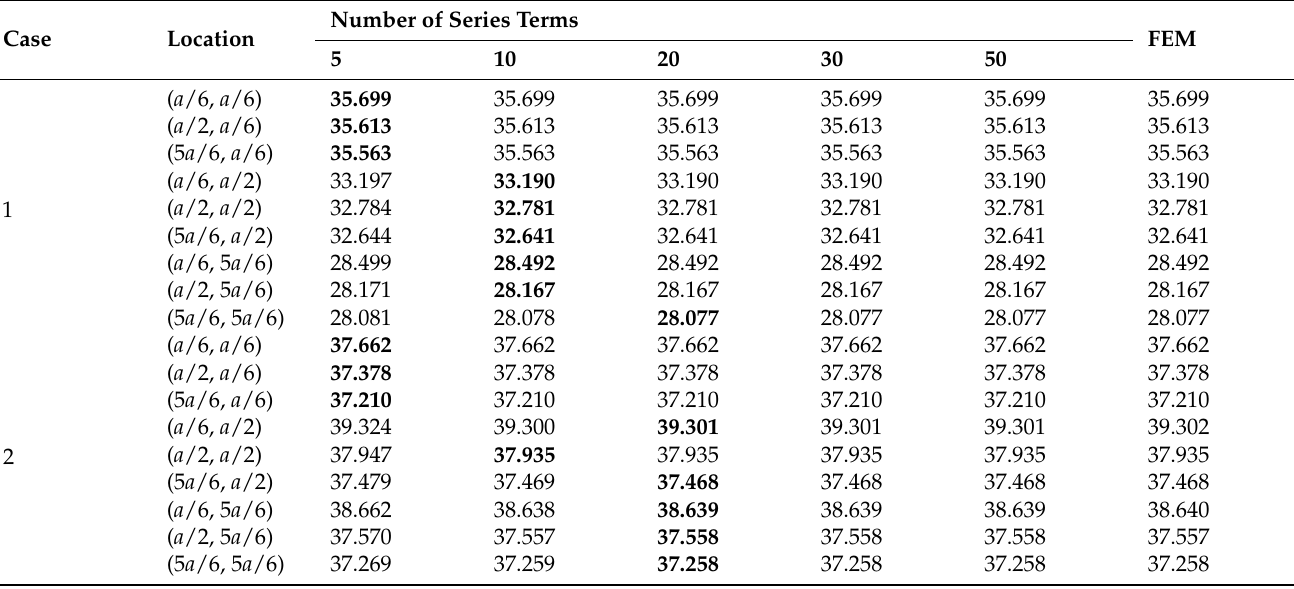
Table 1. Convergence study for the present temperature solutions ( ◦ C) at typical locations when t = 15.0 s.